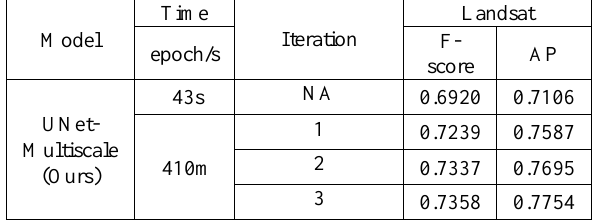
Table 3. Self-training for Landsat-8